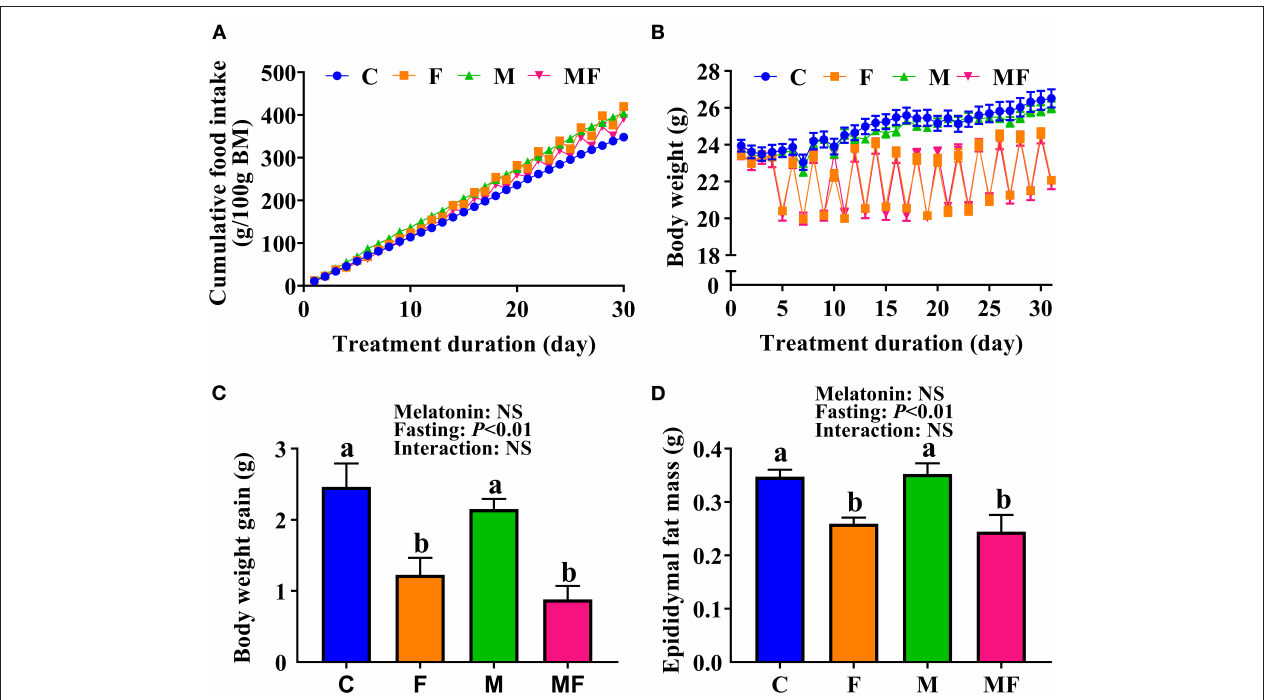
FIGURE 1 | The effects of intermittent fasting and melatonin supplementation on food intake and body weight gain in mice. (A) Cumulative food intake. (B) Body weight. (C) Weight gain after treatment for 30 days. (D) Epididymal fat mass of mice at the end of the experiment. Data are presented as mean ± SEM, n = 12; Labeled means without a common letter differ ( P < 0.05), NS: P ≥ 0.05. C, control; F, intermittent fasting; M, melatonin; MF, intermittent fasting plus melatonin. The C and M mice were fed ad libitum , while the F and MF groups underwent alternative-day feed deprivation. The M and MF groups mice were supplemented with melatonin at a dose of 10 mg/kg body weight by